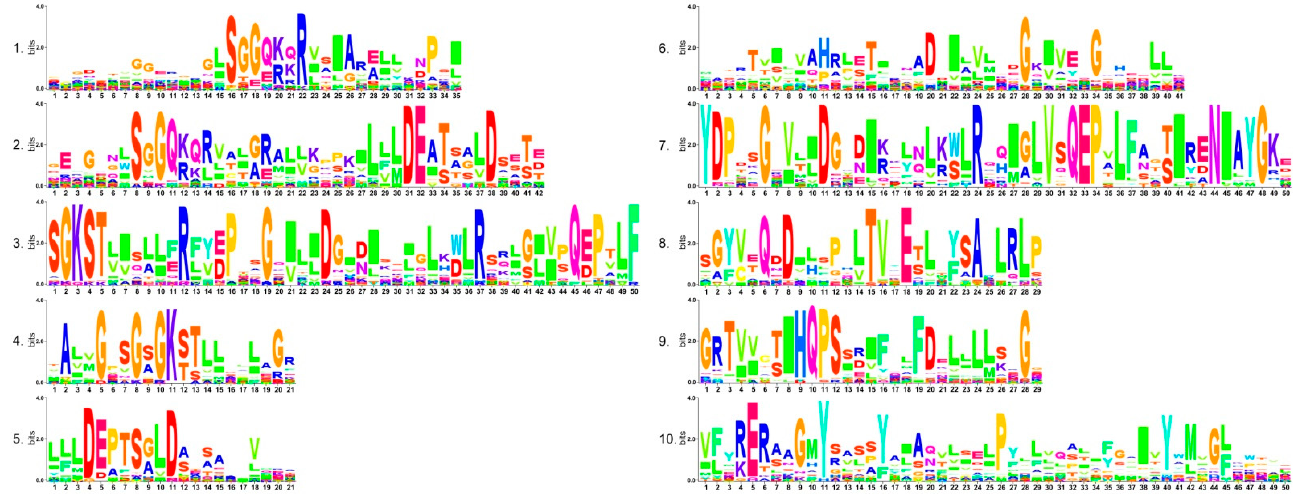
Figure 4. Conserved motifs of ABC transporter proteins in soybean. The conserved motifs of the GmABC proteins were elucidated using the MEME tool.